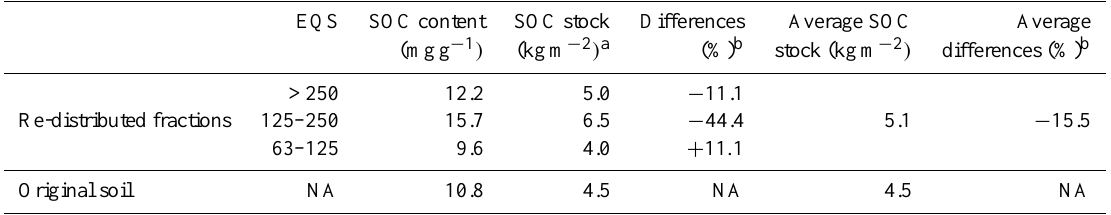
Re-distributed fractions Original soil NA